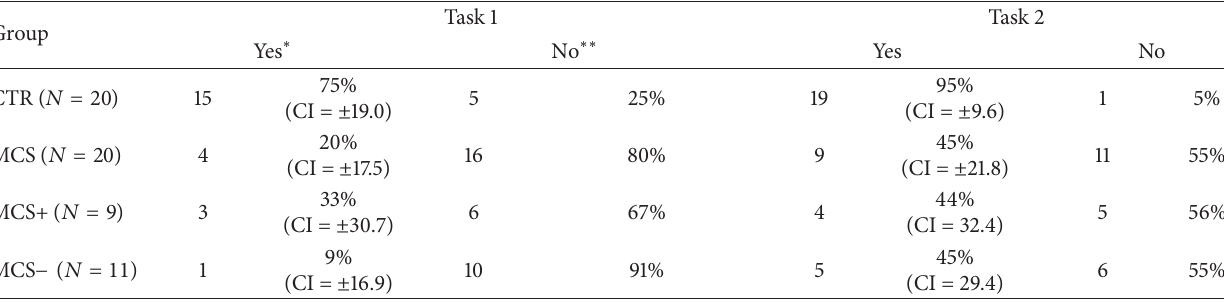
Table 2: Controls and patients classified as responders in tasks 1 and